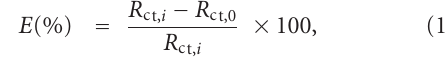
Figure 5. The extrapolation of Tafel straight line allows the calculation of the corrosion current density ( I corr ). The values of I corr , the corrosion potential ( E corr ), cathodic and anodic Tafel slopes ( b c , b a ), and inhibition e ffi ciency ( E %)